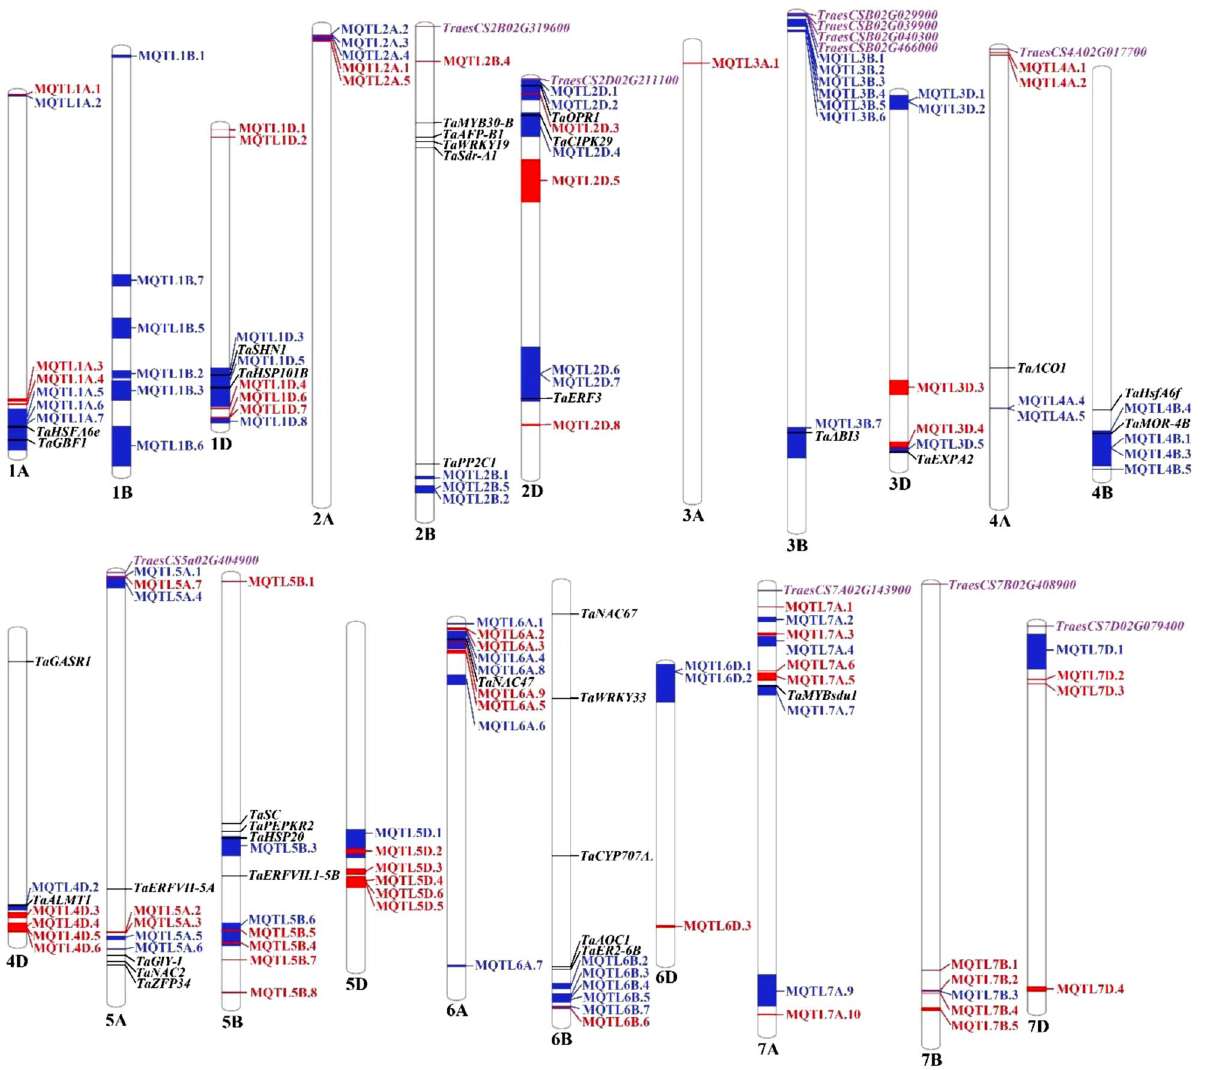
Figure 3. Distribution of MQTLs (GWAS-validated MQTLs are shown with blue) on different wheat chromosomes, differentially expressed candidate genes (showing differential expressions in at least three datasets utilized for expression analysis) are shown with purple, and known genes co-localizing with MQTLs are shown with black (only some important MQTLs are shown